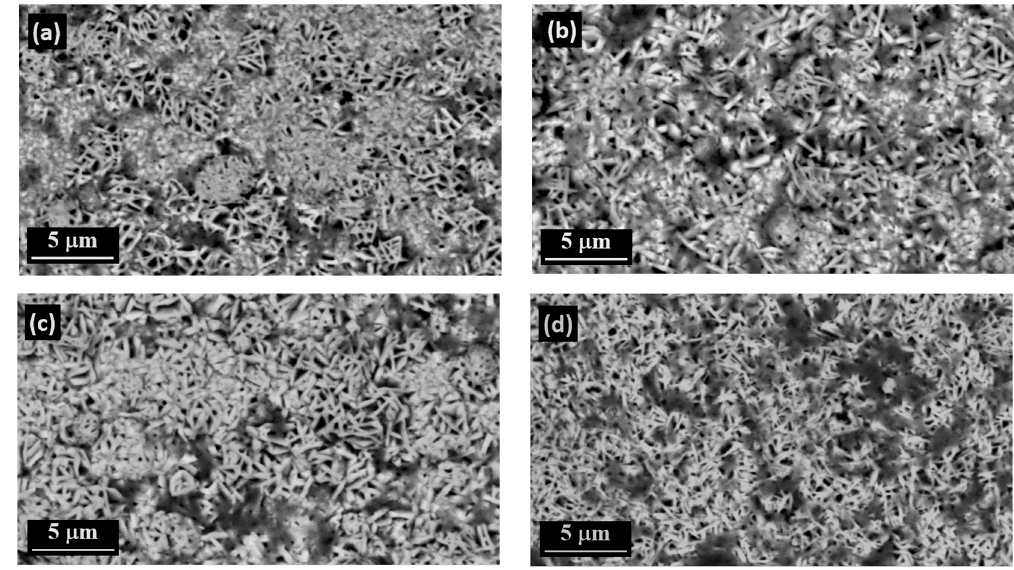
Figure 10. SEM backscatter electrons (BSE) images of the surfaces of Zn–SiC layers formed by PED in the presence of gelatin at j avg = − 3.0 A·dm − 2 , f = 100 Hz, and various values of duty cycle θ : ( a ) 0.2, ( b ) 0.3, ( c ) 0.4, ( d ) 0.5.